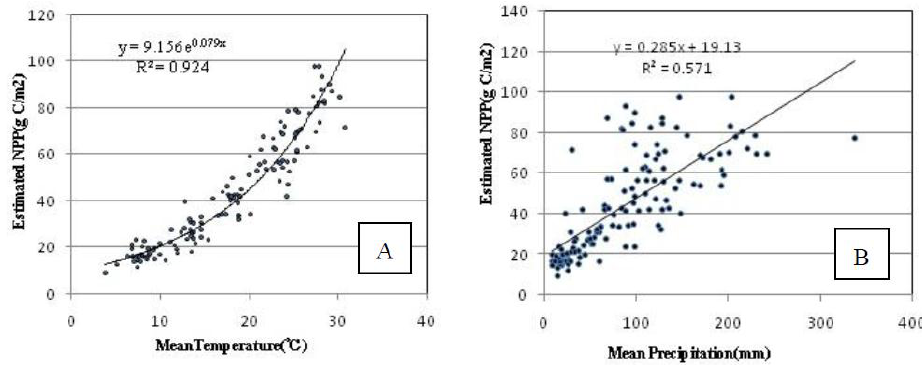
Figure 10. Relationships between estimated NPP and precipitation and temperature ( A , B ).